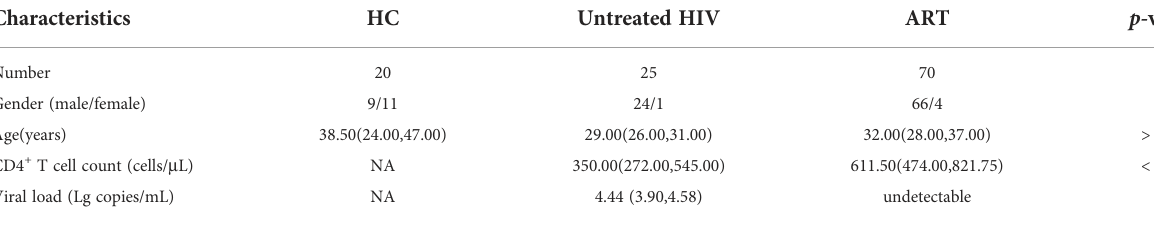
TABLE 1 Clinical characteristics of subjects enrolled in this